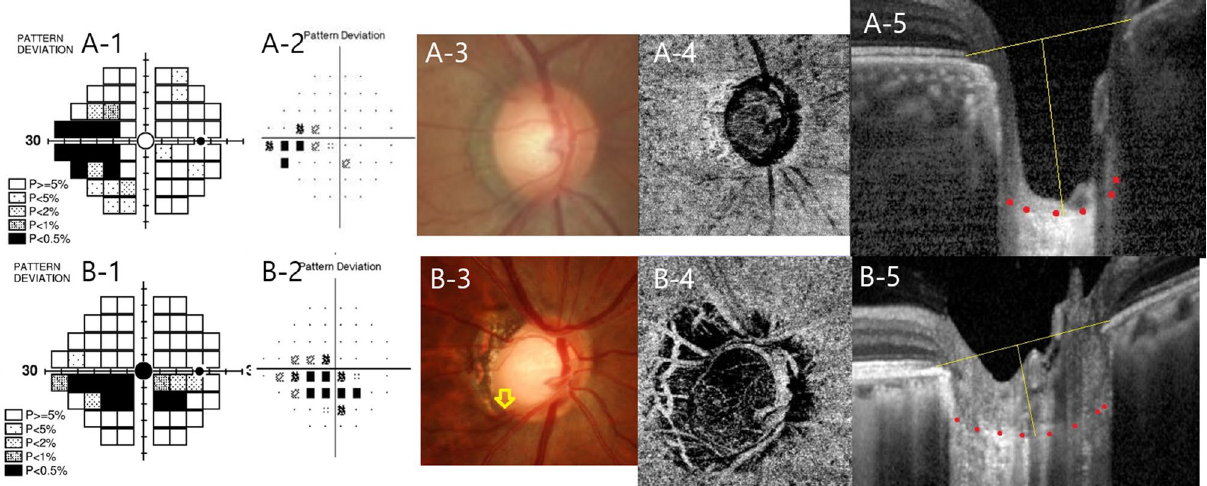
Figure 3. Representative cases of SAP–FDT difference in peripheral nasal step (PNS) and parafoveal scotoma (PFS) in early stage of open-angle glaucoma. ( A ) A 51-year-old woman with PNS presented with great SAP– FDT difference. ( A-1,A-2 ). Lamina cribrosa depth (LCD) of 727 μm and lamina cribrosa curvature index (LCCI) of 19.21 was larger ( A-5 ) than those of eye with PFS ( B-5 ). ( B ) A 50-year-old man with PFS presented with 14 abnormal points in FDT and 16 abnormal points in SAP ( B-1,B-2 ). Fundus photography showed disc hemorrhage (yellow arrow) ( B-3 ). Peripapillary choroidal VD of 53.80% was low ( B-4